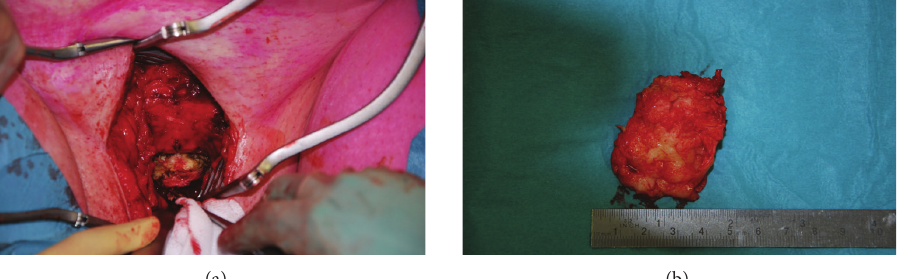
Figure 3: Case 2. A 56-year-old postmenopausal lady presented with voiding dysfunction. (a) Operative picture of smooth, rounded, firm, and cystic mass, at the anterior vaginal wall of about 4cm width connected to the pubic symphysis. (b) Postoperative picture of the excised